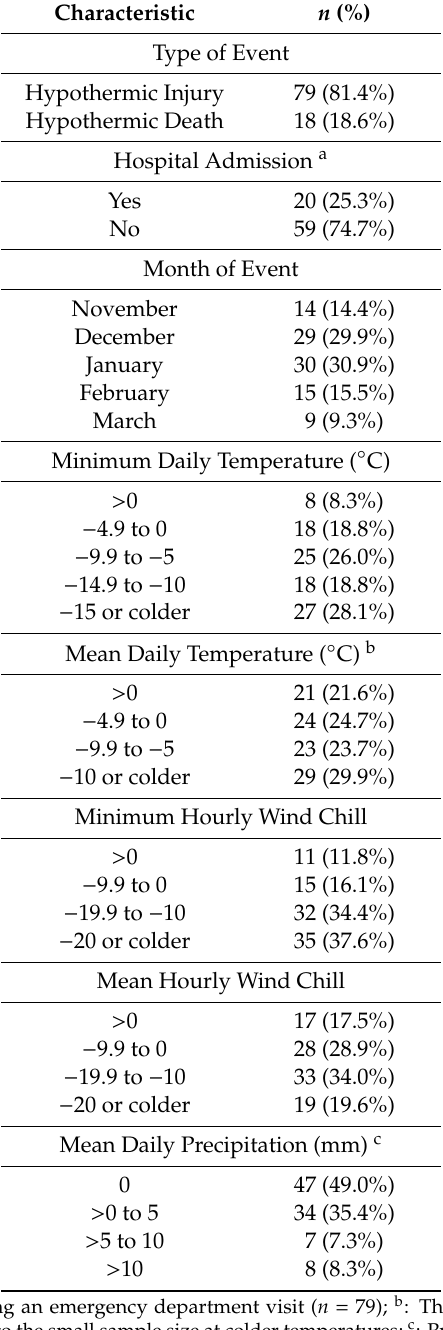
Table 1. Characteristics of the hypothermic events among the homeless population in Toronto from